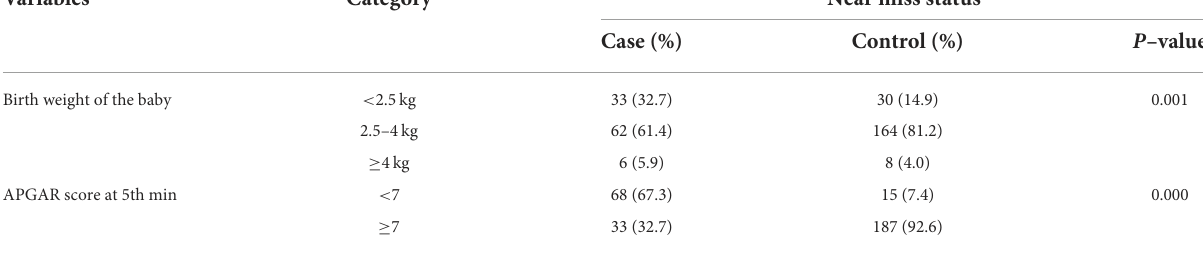
TABLE 5 Neonatal–related characteristics of NNM among neonates admitted ( n = 303) to public hospitals of Ilu Abba Bor Zone, 2020.